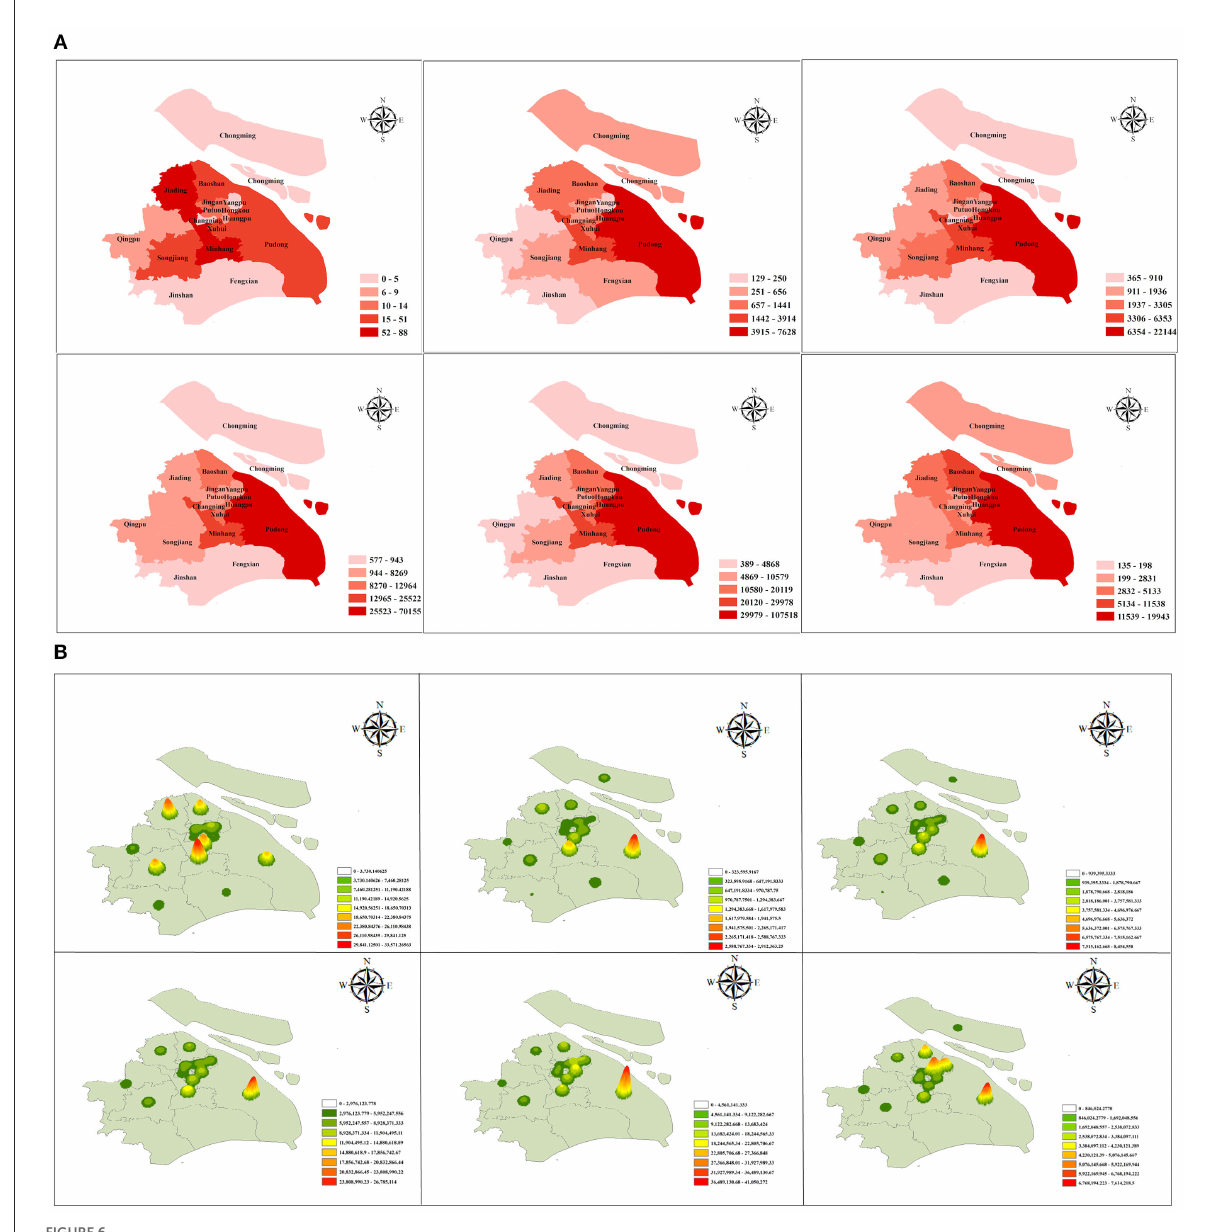
FIGURE6 The spatial distribution of the epidemic. (A) A geographical map and (B) a nuclear density map showing the spatial distribution of local cases in Shanghai, divided into 16 districts. The six submaps represent the six stages of epidemic development. Limited by media reports, this article covers only the period from March 5 to May